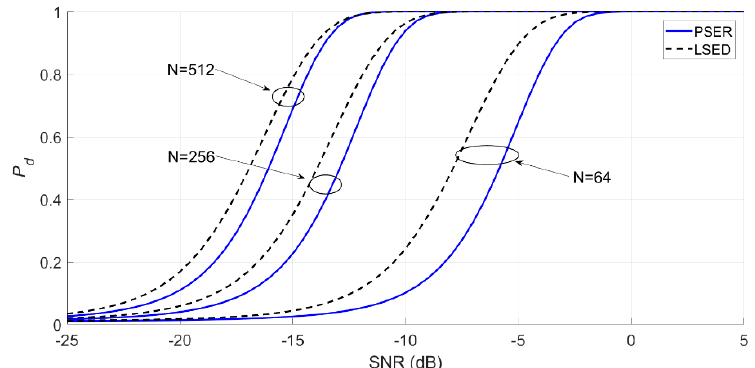
Figure 7. Detection probabilities of the PSER and LSED when the full spectrum bin number varies ( N = 64, 256, and 512; d = 20; P f = 0.01; a = 1).